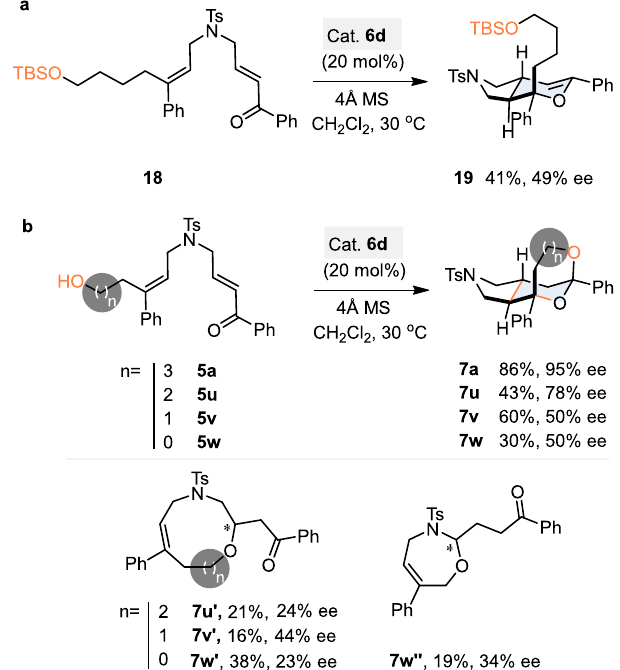
Fig. 6 Probing the HB interaction. a IEDHDA reaction with a substrate lacking the HB donor. b Effect of the HB donor-alkene linker size on the